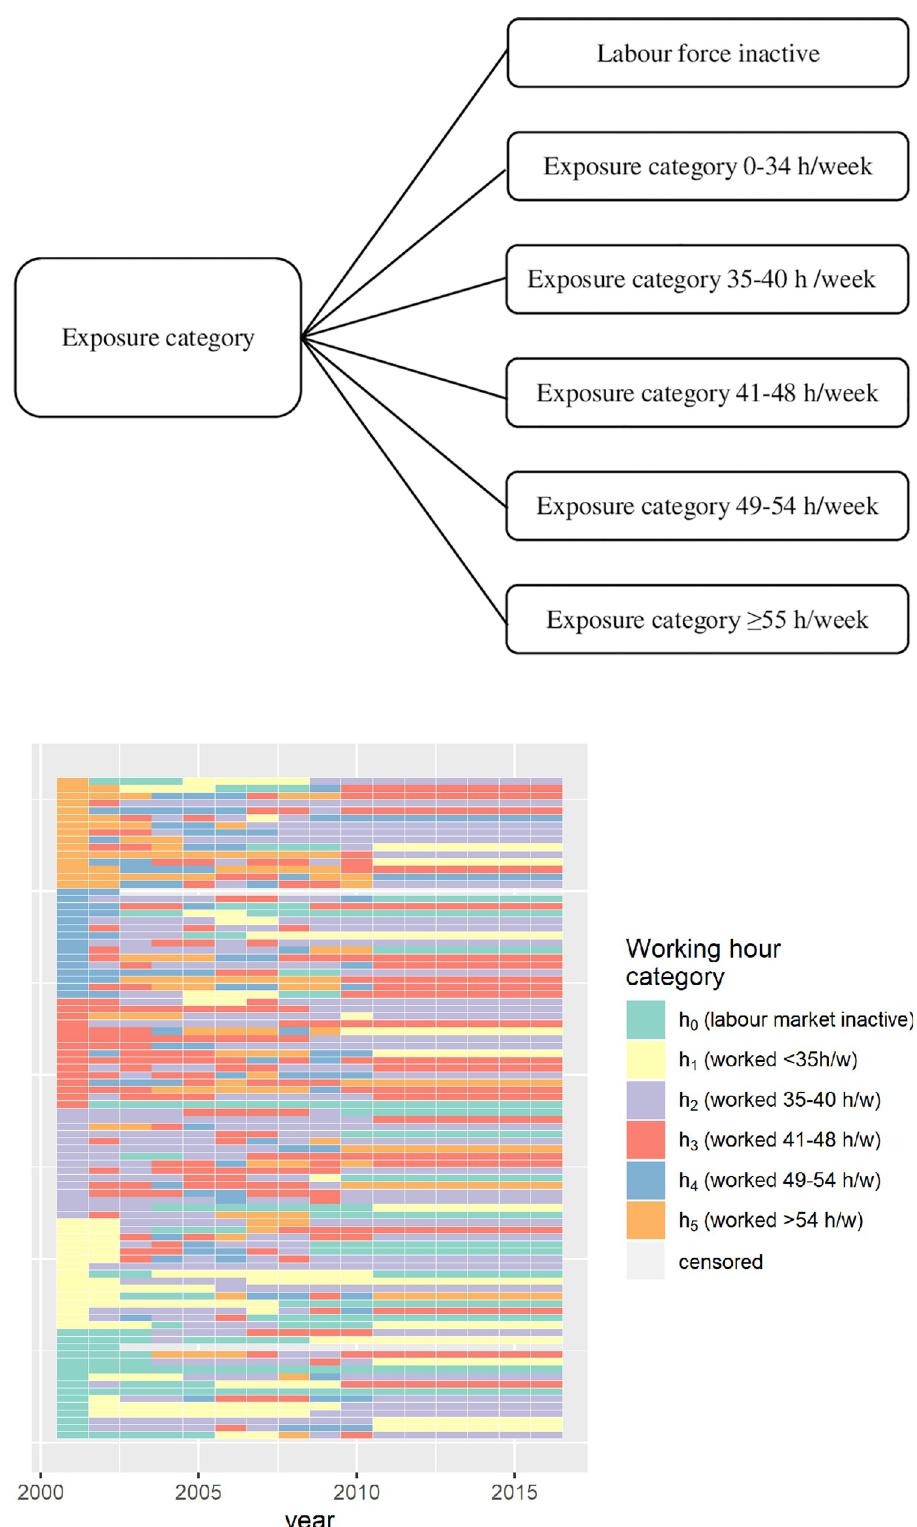
Fig 3. a) Monte Carlo method based probabilistic model for transitions of a synthetic individual. The possible transitions from an exposure category at time year were into exposure categories labour force inactive, 0–34 t